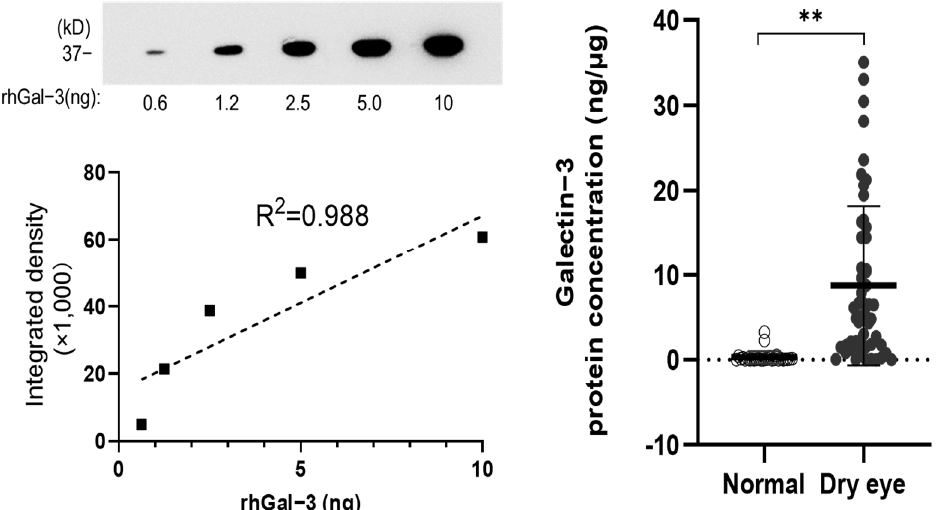
Figure 1. ( Left ) Standard curve of a two-fold serial dilution series of recombinant human galectin-3 (rhGal-3). ( Right ) Analysis of galectin-3 concentrations in tears included 52 dry eye disease samples (28 patients), and 28 normal eye samples (14 healthy volunteers) by immunoblotting. ** p < 0.01.